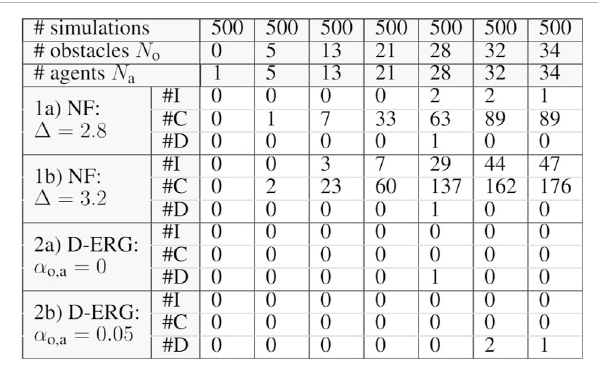
TABLE 2 | Simulation Statistics on Safety and Goal Satisfaction − A cubic environment is randomly and increasingly densely fi lled with N o spherical obstaclesand N a sphericalagentsdoing3Dpointtopointtransitions.Thenumber of simulations that contain at least one instability, collision, or deadlock are denoted by #I, #C, and #D, respectively. Almost global asymptotic stability, with no collisions and no instabilities con fi rm the strong safety certi fi cates of the D-ERG. This compared with another explicit approach solely based on Navigation Fields (NF).